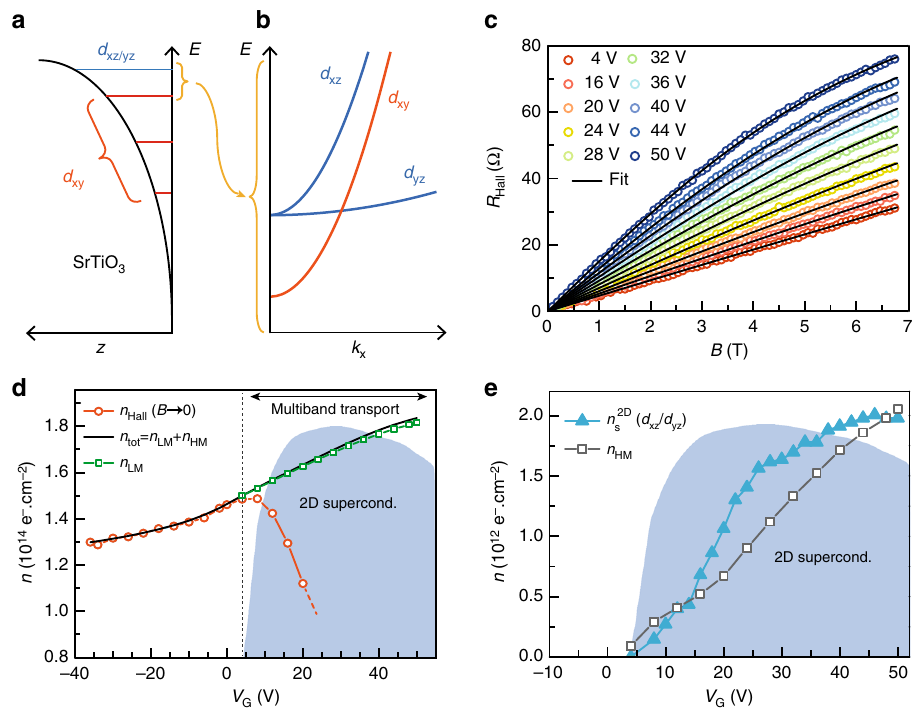
Fig. 5 Super fl uid density and Hall effect analysis. a Scheme of the interfacial quantum well showing the splitting of the t 2g bands. b Simpli fi ed scheme of the band structure taking into account only the last fi lled d xy subband, the d xz band, and the d yz band. c Hall resistance as a function of magnetic fi eld for different V G > 0 (open circles), fi tted by at two-band model (black solid lines) (see Methods). d Hall carrier density n Hall ¼ B eR extracted in the limit B → 0 Hall (red open circles) and LMC density n LM extracted from the two-band analysis (green open squares). The total carrier density n tot is obtained by matching the charging curves of the gate capacitance with n Hall at negative V G (black solid line). The unscaled T c dome in the background indicates the region where superconductivity is observed. e Super fl uid density n 2D calculated from J exp using a mass m xz/yz (plain triangles), compared with the HMC density n HM s s (open